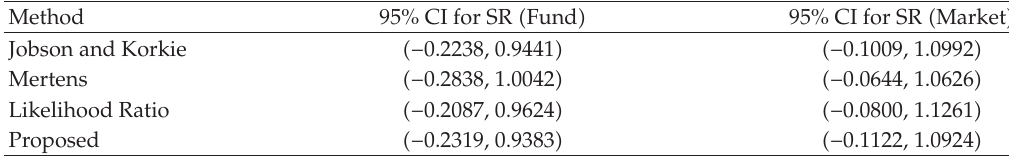
Table 2: 95% Confidence Intervals for the sharpe